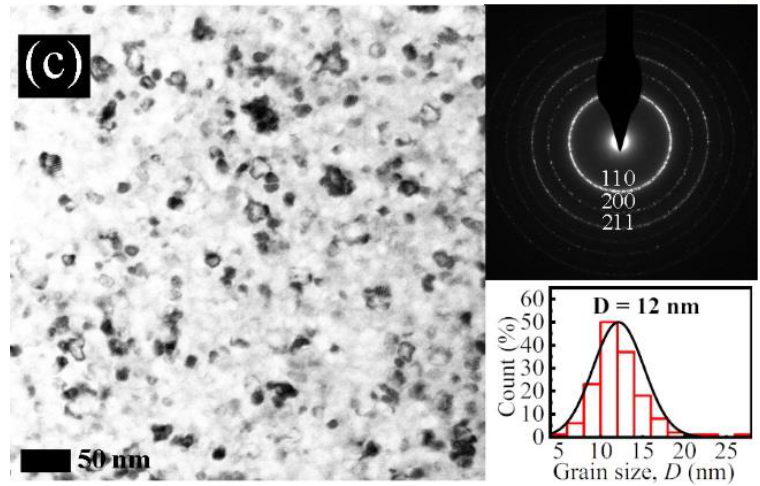
Figure 7. TEM micrographs, SAED and characteristic grain size distribution of ( a ) B 9 Si 12 , ( b ) B 8 Si 12 P 1 and ( c ) B 9 Si 11 P 1 ribbons annealed at 550 °C for 60 min.